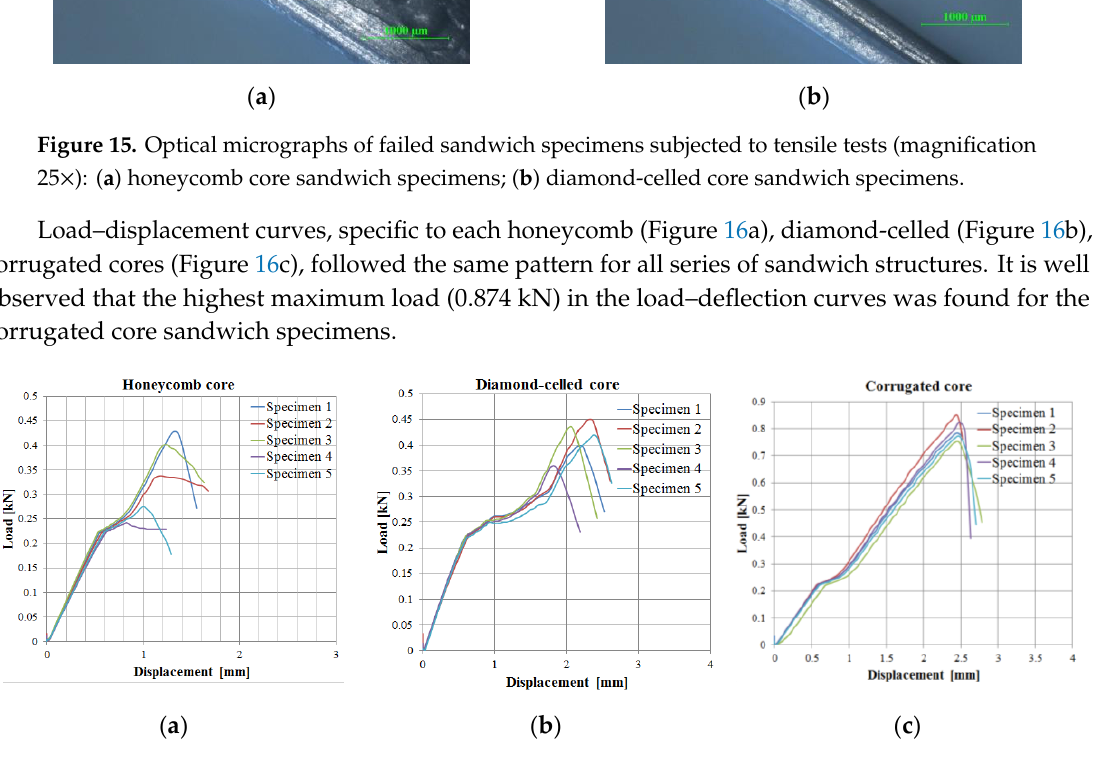
Figure 16. Load–displacement curves obtained from three-point bending tests: ( a ) honeycomb core; ( b ) diamond-cell core; ( c ) corrugated core.